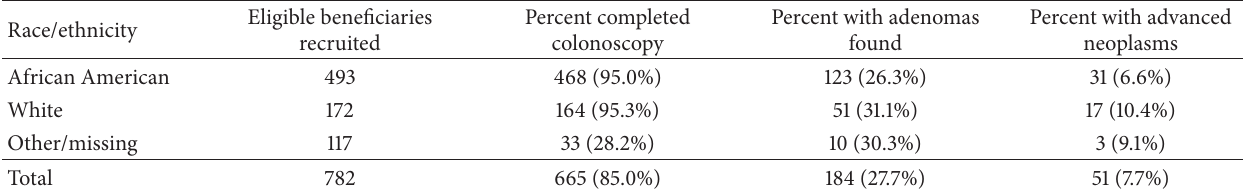
Table 3: SCOPE SC performance in addressing racial disparities in colorectal